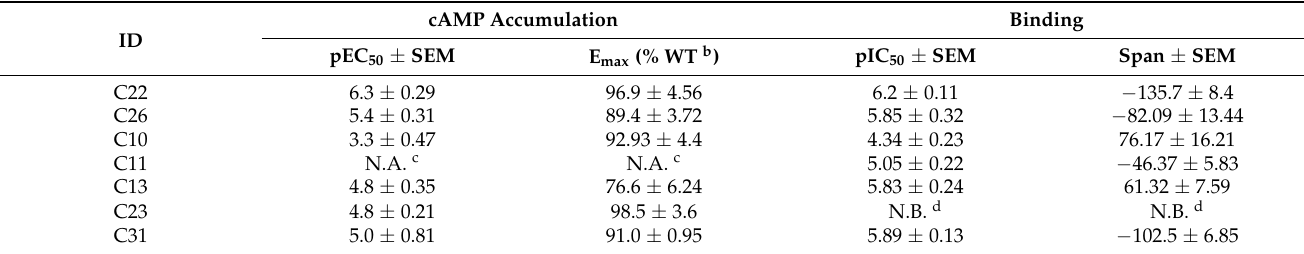
Table 3. Experimentally validated new PAMs based on LBVS approach a .